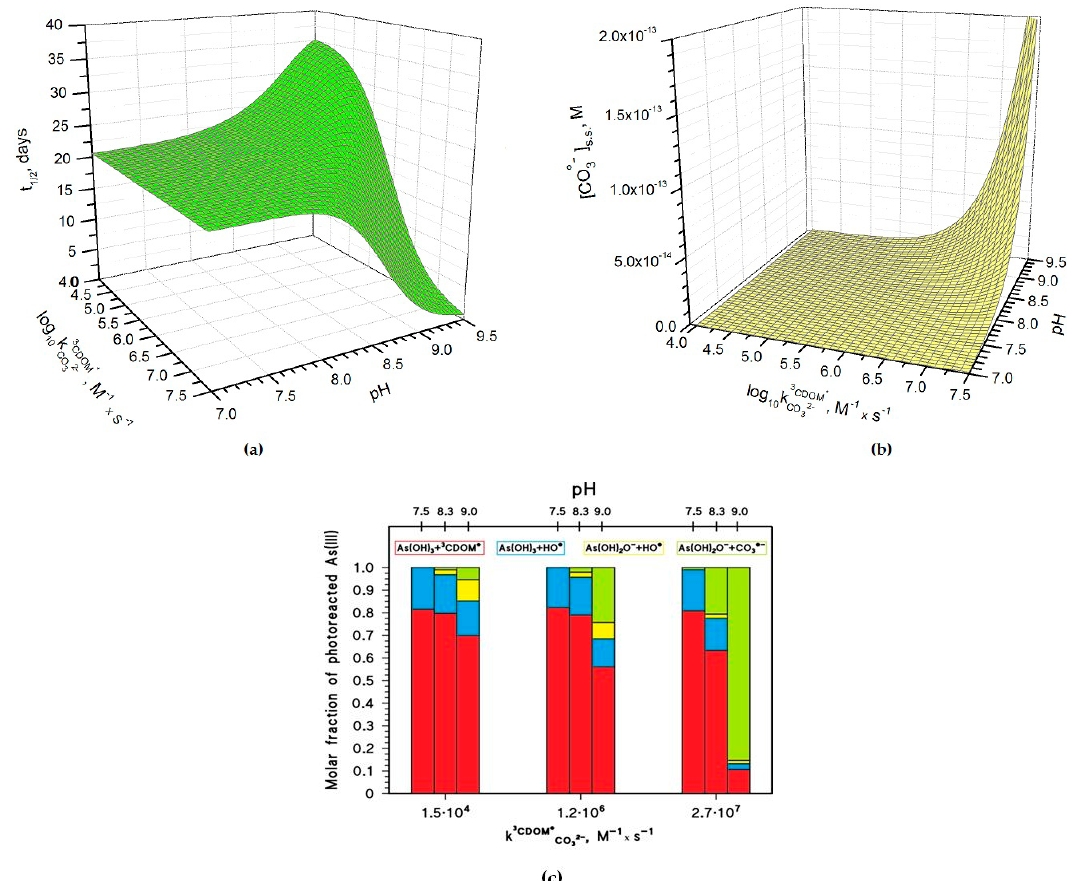
Figure 4. Photochemical parameters of As(III) photooxidation computed for the month of May. Water conditions: 5 cm depth, 0.1 mM NO 3 − , 1 µ M NO 2 − , inorganic carbon (IC) = 1.1 mmol · C · L − 1 , and DOC = 7 mg · C · L − 1 . ( a ) Half-life time of As(III) and ( b ) steady-state concentrations of the carbonate radicals, as a function of pH and of the decimal logarithm of k 3 CDOM ∗ . The days are referred to average irradiance conditions occurring at mid-latitude in mid-May. ( c ) Roles of the main reactions accounting for the photooxidation of dissolved As(III). The k 3 CDOM ∗ values used in ( c ) are those reported for the three CDOM proxy molecules 3’-methoxyacetophenone (1.5 · 10 4 M − 1 · s − 1 ), benzophenone (1.2 · 10 6 M − 1 · s − 1 ) and duroquinone (2.7 · 10 7 M − 1 · s − 1 ) [23].